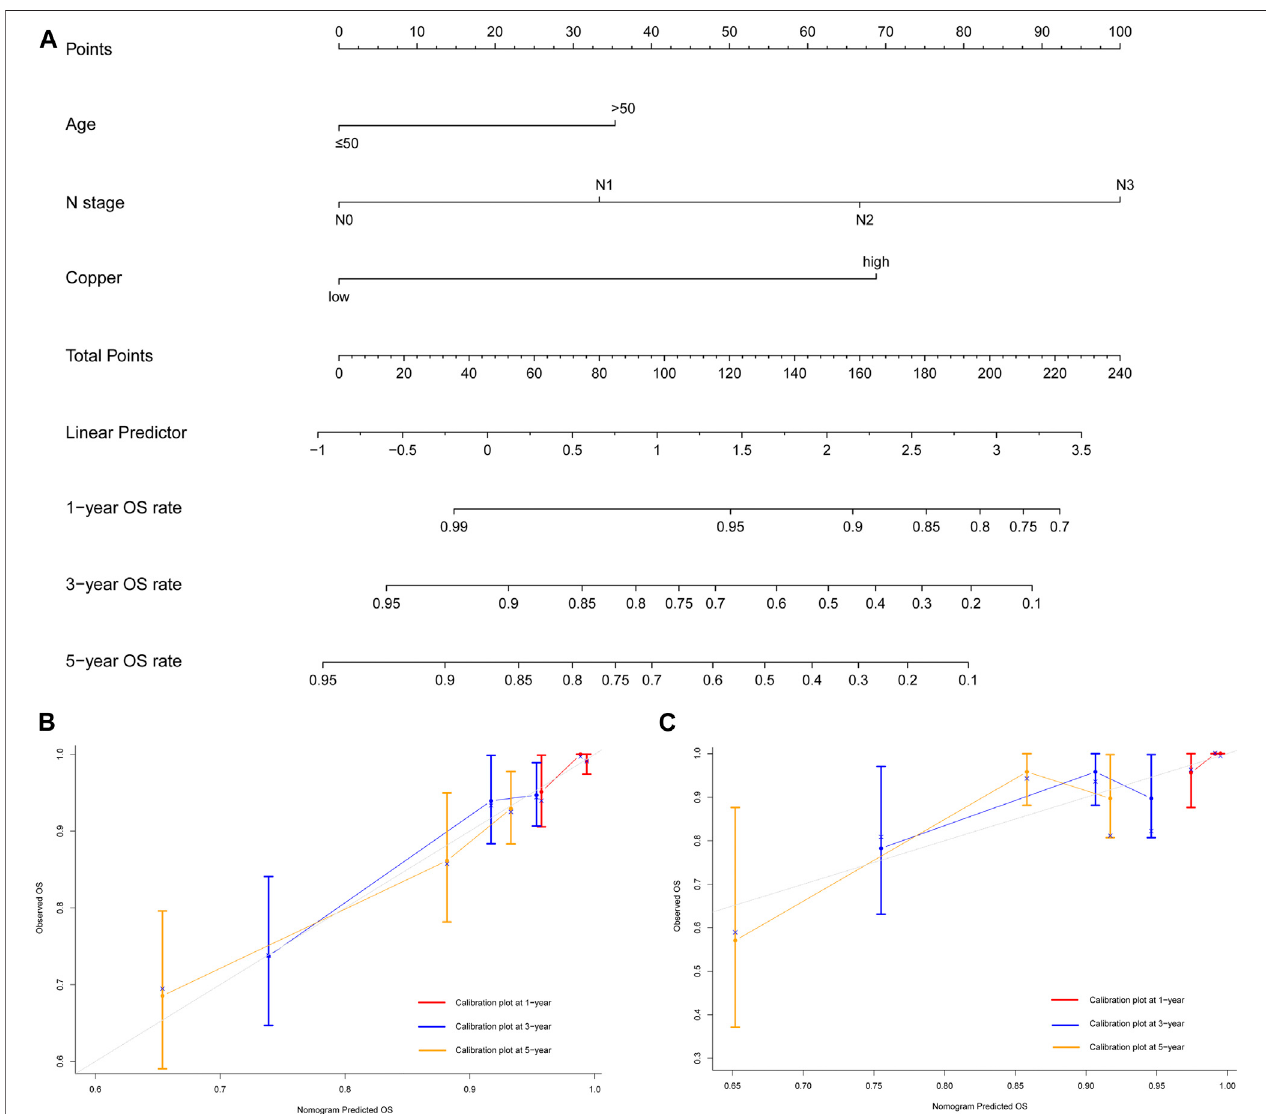
FIGURE 6 | Development and validation of prognostic model for individualized prediction of overall survival (OS). (A) Nomogram of current prognostic model for patients with early-stage triple-negative breast cancer. (B) Calibration curves for predicting OS at 1-, 3-, and 5-years in the training cohort. (C) Calibration curves for predicting OS at 1-, 3-, and 5-years in the SYSUCC-001 cohort.